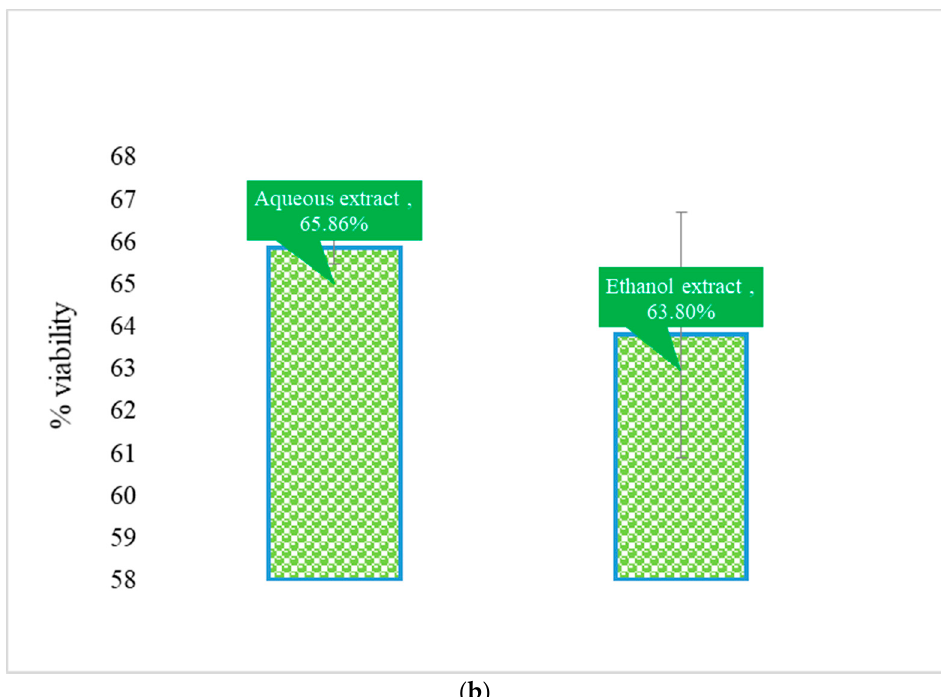
Figure 2. ( a ) Chloroquine @ 0.010 µM IC 50 ; ( b ) % viability of Plasmodium falciparum strain with water and ethanol extracts.